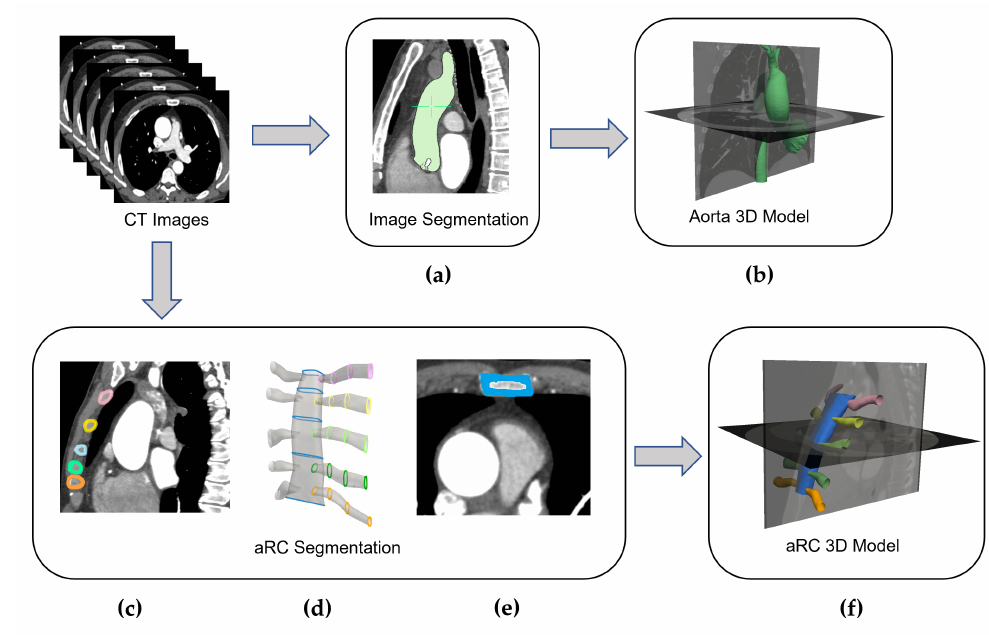
Figure 1. Procedure for aorta and aRC 3D models